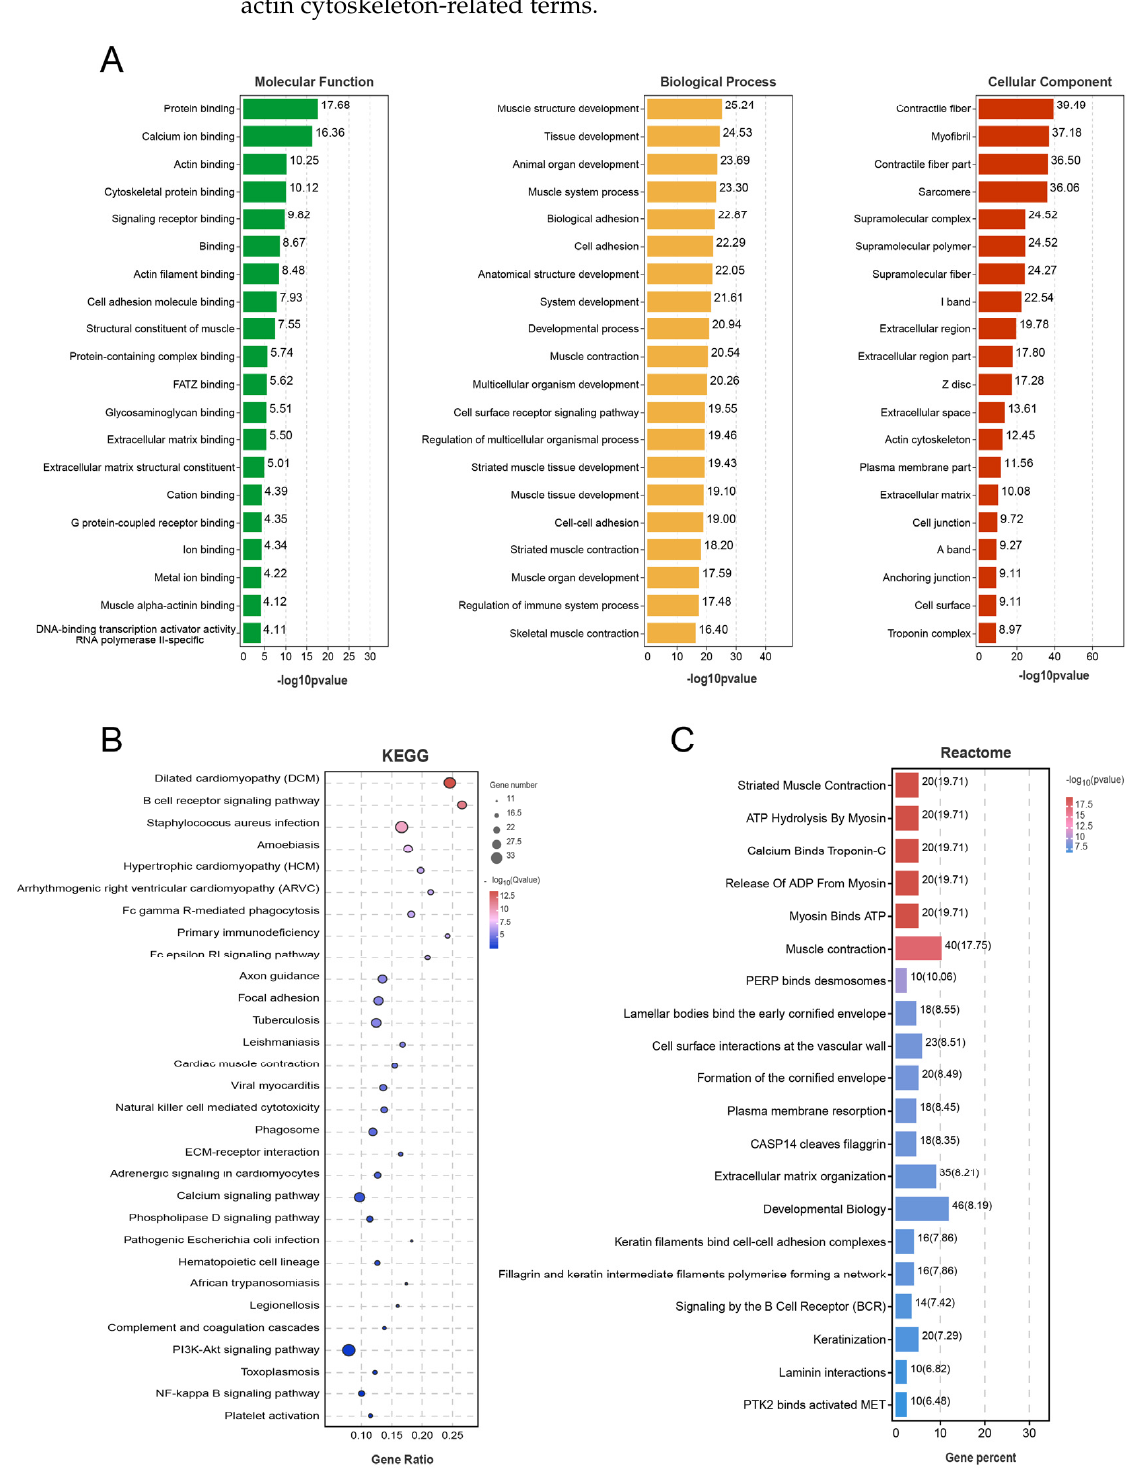
Figure 6. Results of differentially expressed genes enrichment. ( A ) GO enrichment analysis bar chart. ( B ) KEGG enrichment factor map. ( C ) Reactome enrichment analysis bar chart. Significant enrichment analysis was performed based on all significantly DE